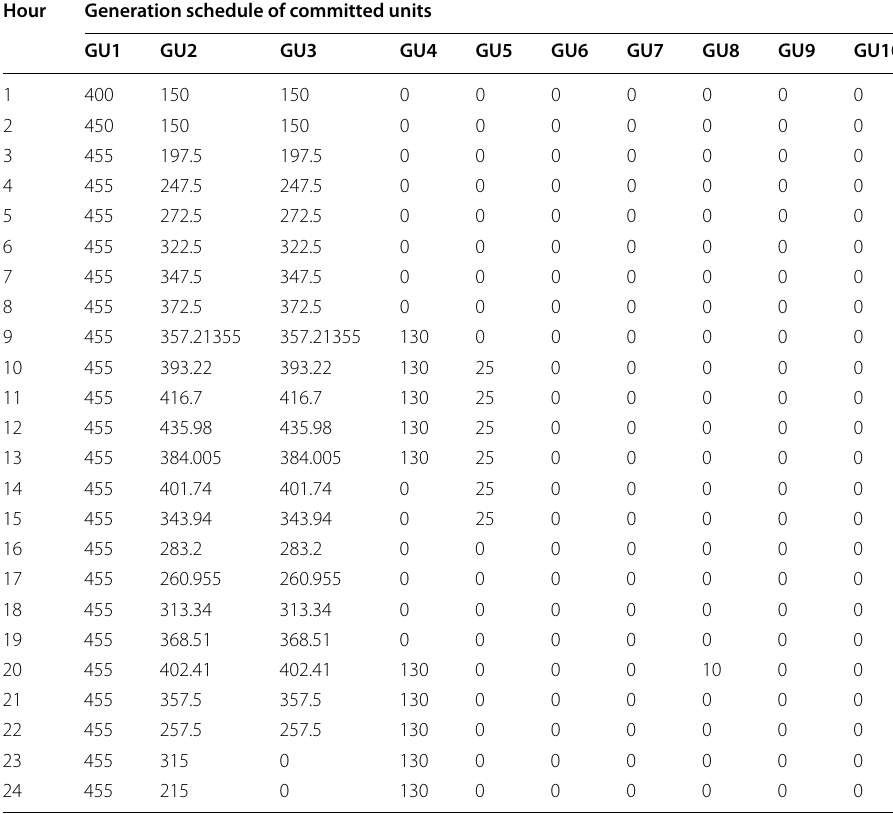
Table 15 Power scheduling for 10-generating unit system (10% SR) considering renewable energy in